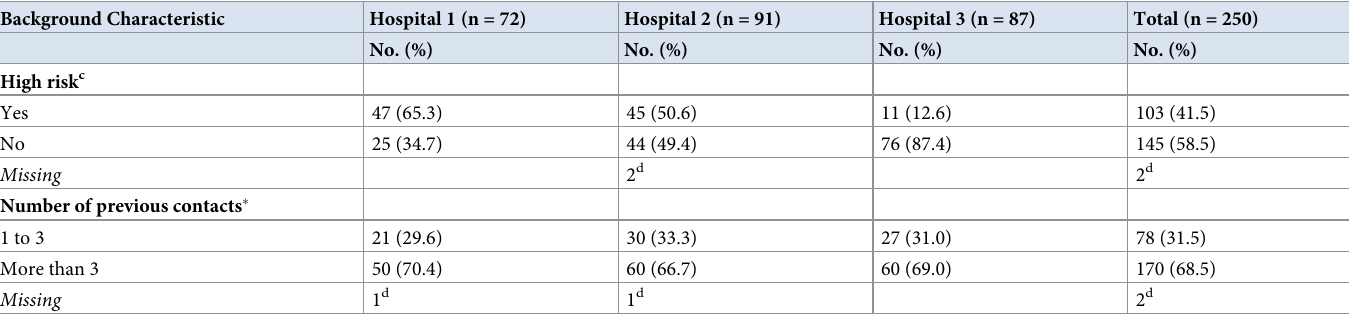
Maternity cards. The standard government issue yellow women-held maternity